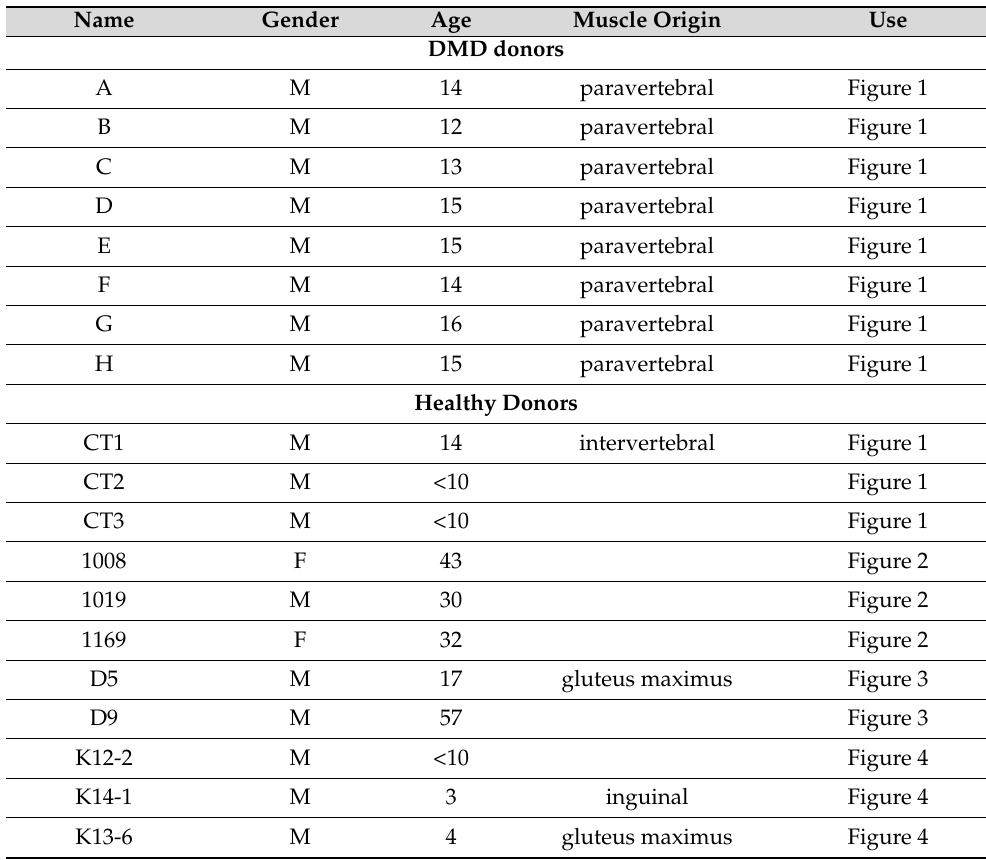
Table 1. Characteristics of healthy and DMD